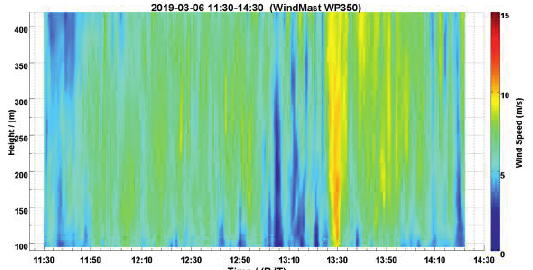
Figure 5. Wind THI diagram from 11:30 to 14:30BJT on 6 March 2019 observed by WP350